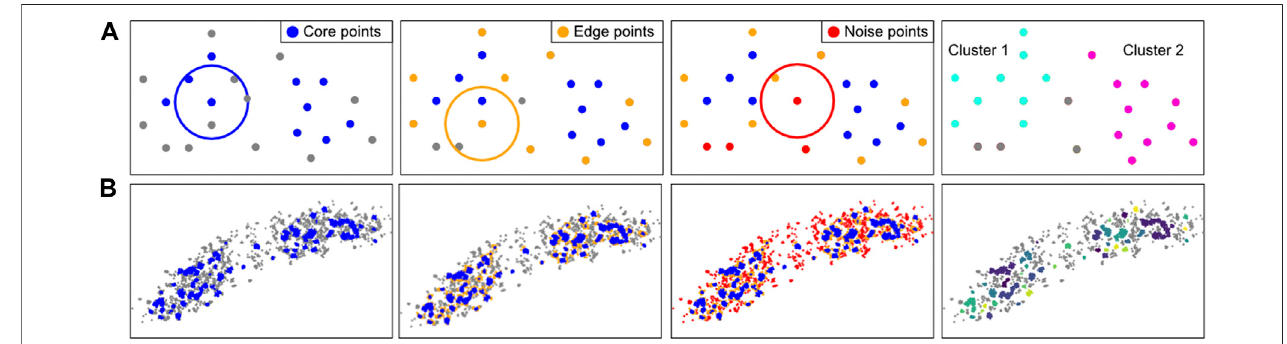
FIGURE8| ComputationalapproachoftheclusteringmethodDBSCAN. (A) :DBSCANexplanation.ForeverylocalizationinagivenFoV,thenumberofneighbours in auser-de fi ned radius are counted. Ifthere aremore neighboringpoints than a(by theuser) set minimal number ofpoints (left), these points are considered corepoints (blue). All localizations that are not core points, but have a neighbour that is a core point, are considered an edge point (orange, second panel). Localizations that have neitherenoughneighboursnorproximalcorelocalizationsareconsiderednoisepoints(red,thirdpanel).Thecoreandedgelocalizationstogetherareconsideredto form a cluster. The identi fi ed clusters can be visualised and characterized (right). In this example, at least 3 neighbours are required for a localization to be considered a core point in the radius indicated by the circle. (B) : Application of the DBSCAN steps on an E. coli cell with fl uorescently-labeled RNA